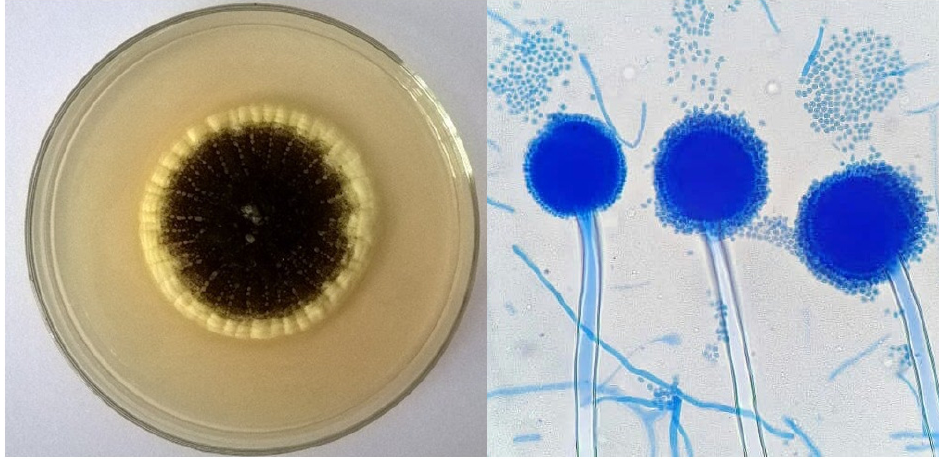
Figure 2. Images of Aspergillus japonicus in the dish, as well as pictures of the spores under a light microscope at 400× magnification.